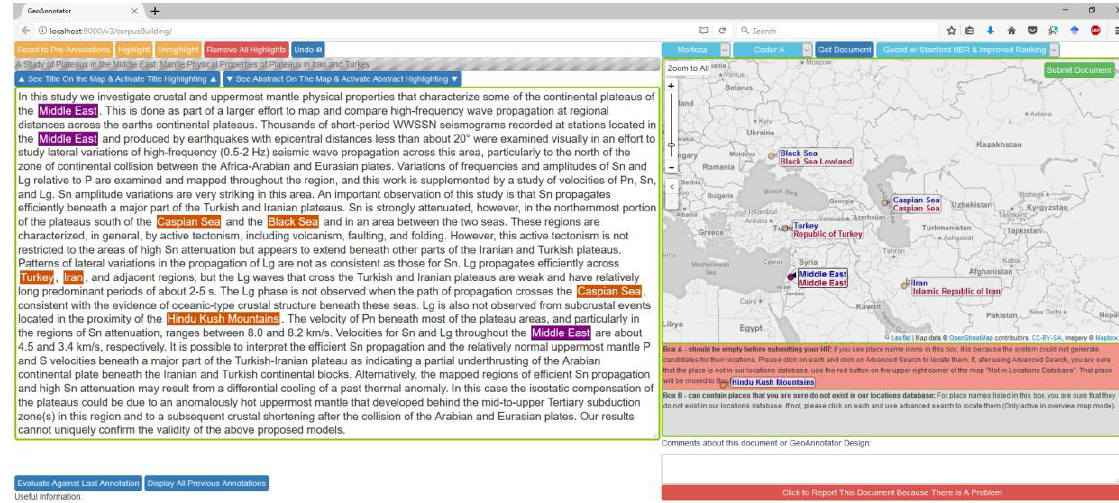
Figure 8. GeoAnnotator’s UI main window, with the second document part (abstract) being active for geo-annotation. Upon hovering the mouse pointer over the “Middle East” toponym on the map, all instances of “Middle East” in text will be highlighted in purple (and vice versa). “Black Sea” is not geolocated correctly, and no toponym is found for “Hindu Kush Mountains” by the system. The user can manually correct both of these issues.